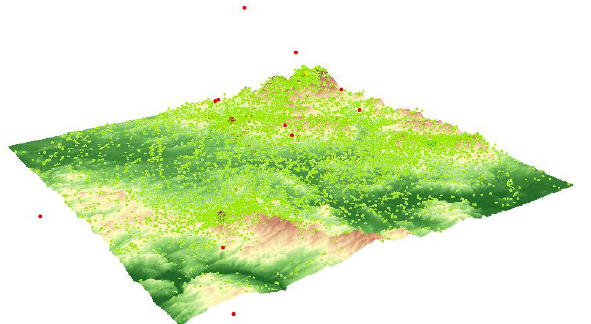
Fig. 5. Raw data displayed as a layer in GIS-software (green points – calculated 3D gaze data; red – points with incorrect elevation).